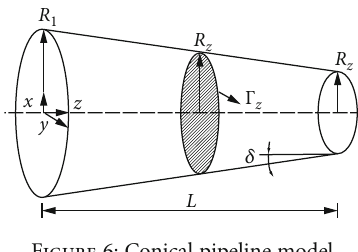
Figure 6: Conical pipeline model.